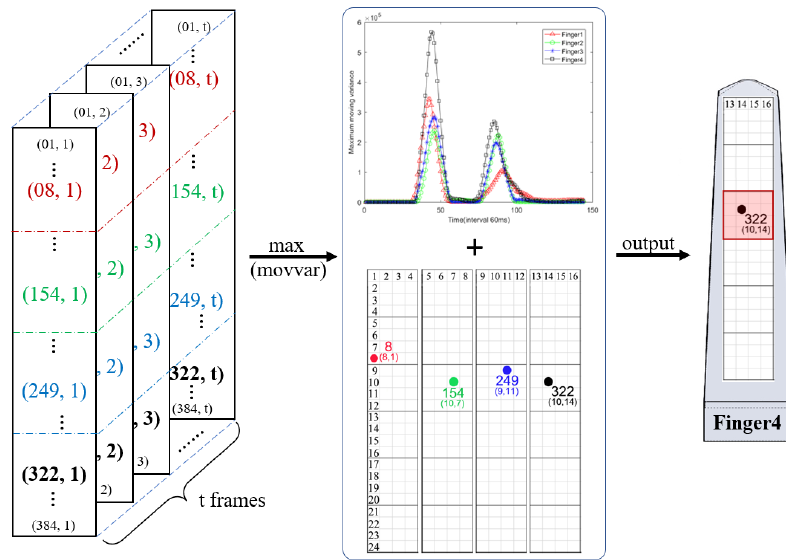
Figure 6. Interference